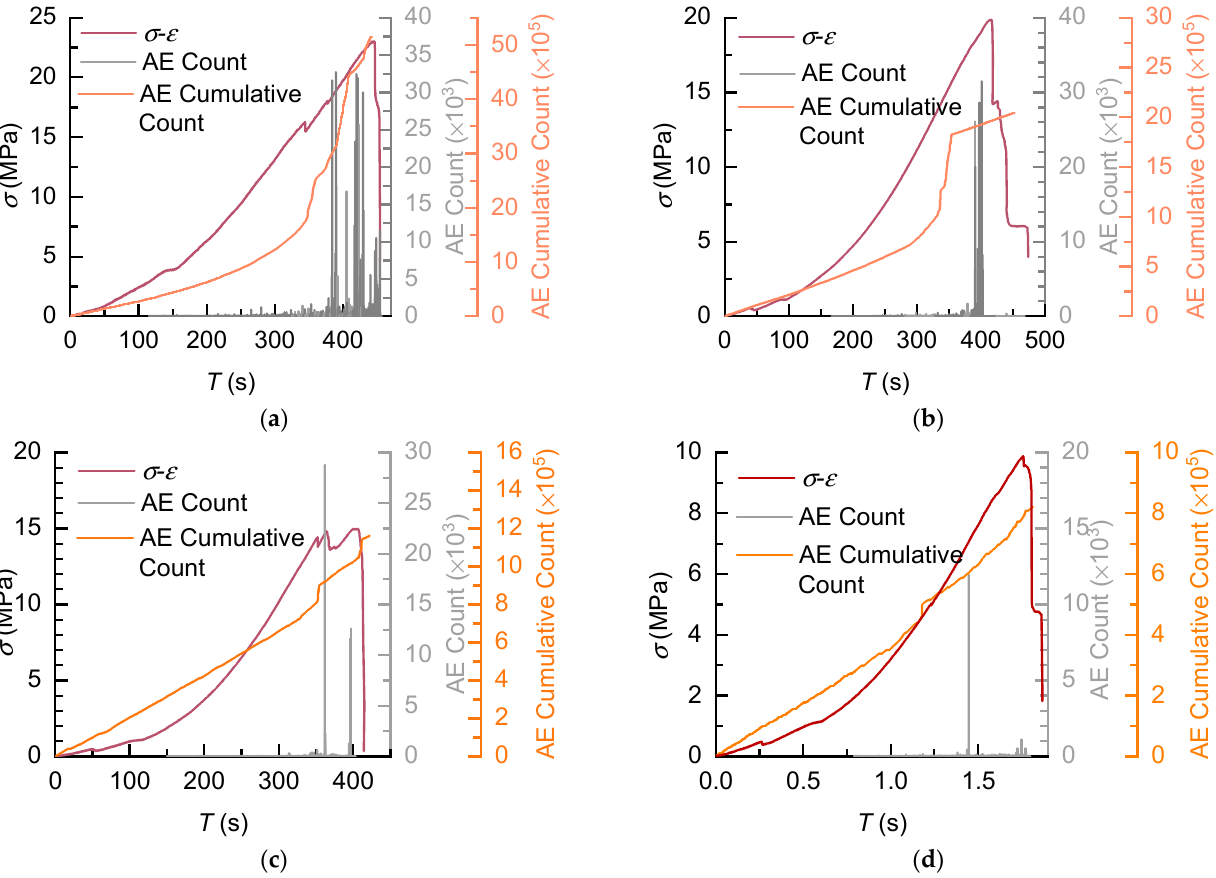
Figure 11. Acoustic emission characteristic profile of coal samples at various aquiferous content. They should be listed as: ( a ) w = 0%; ( b ) w = 4.35%; ( c ) w = 8.12%; ( d ) w = 12.32%. Table 2. Statistical table of acoustic emission peak count and cumulative count of coal samples in different water states.